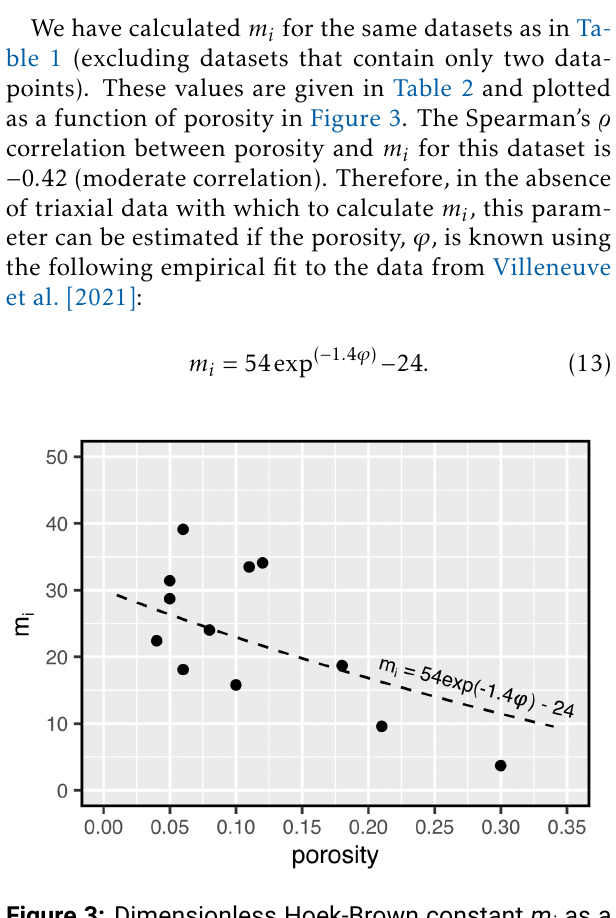
Figure 3: Dimensionless Hoek-Brown constant m i as a function of porosity for a range of volcanic rocks and textures (andesite, basalt, dacite, and tuff), calculated from published triaxial data (data in Table 2). The stan- dard error of the estimate is